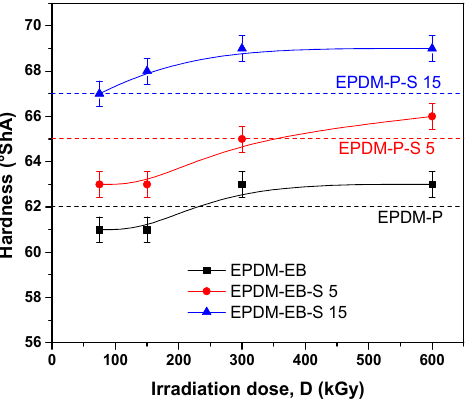
Figure 1. The influence of sawdust amount and the cross-linking method (P/EB) on composite hardness.